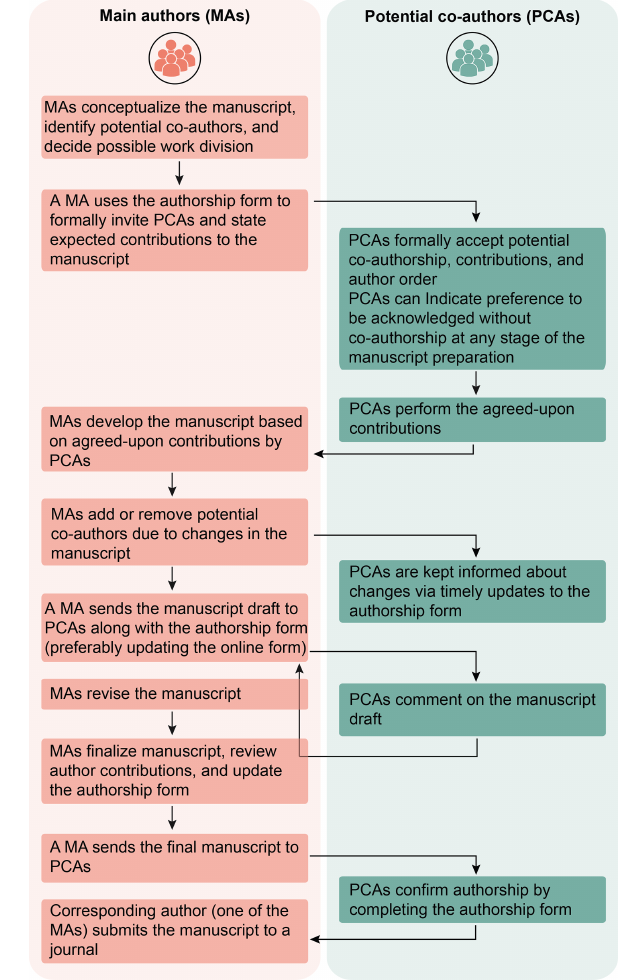
Figure 2. Flowchart describing the process of using the authorship